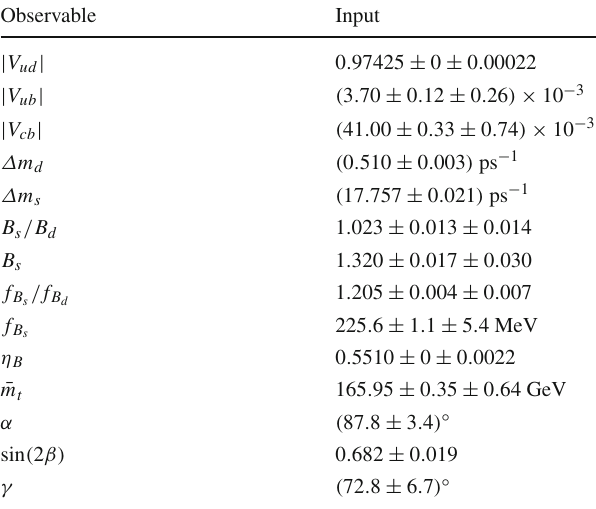
Table 12 Inputs for the theory-dominated CKM fits, inspired by the data available in Summer 2014. Scenario A is restricted to the upper part of the table, whereas Scenario B includes all